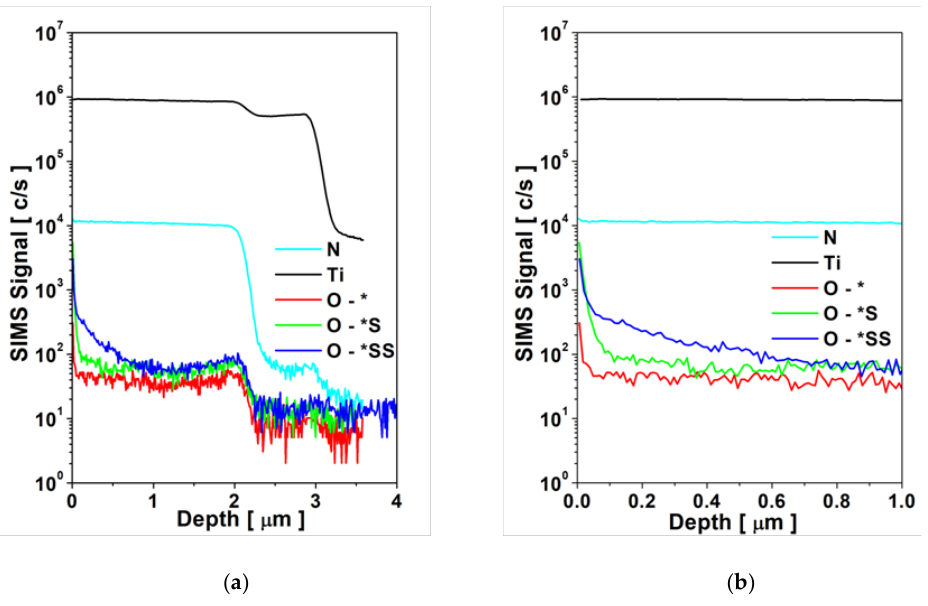
Figure 5. Comparison of oxygen distribution (SIMS) in the TiN-Ti zone of the composite TiN-Ti-Al type titanium nitride layers on AZ91D magnesium in as-deposited state and after hydrothermal treatment: O -* — as-deposited layer (TiN2Ti1Al10); O -*S — hydrothermally treated layer in boiling water bath (TiN2T11Al10_S); O -*SS — hydrothermally treated layer in overheated steam (TiN2T11Al10_SS): ( a ) distribution across the TiN-Ti near surface layer; ( b ) distribution in the vi- cinity of the surface.